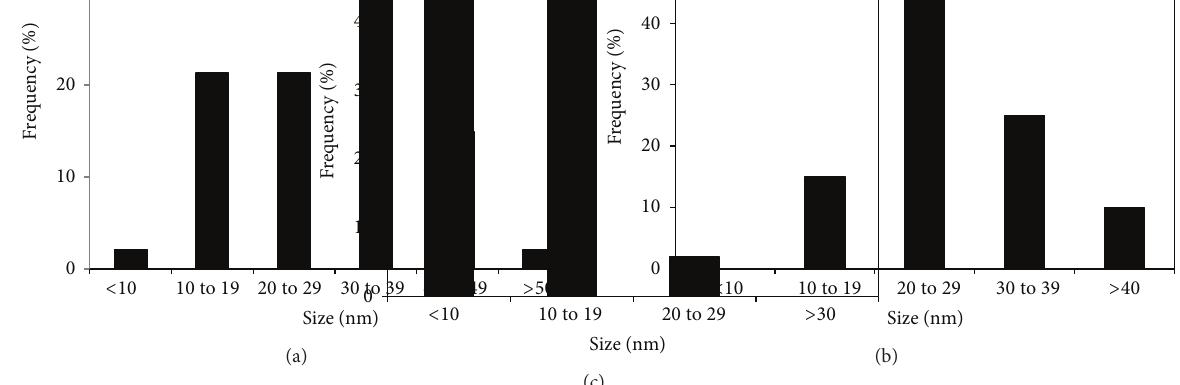
(c) Figure 5: Particle size histogram of GNPs synthesized at different pH of ECF: (a) pH 5, (b) pH 8 (inherent pH), and (c) pH10.